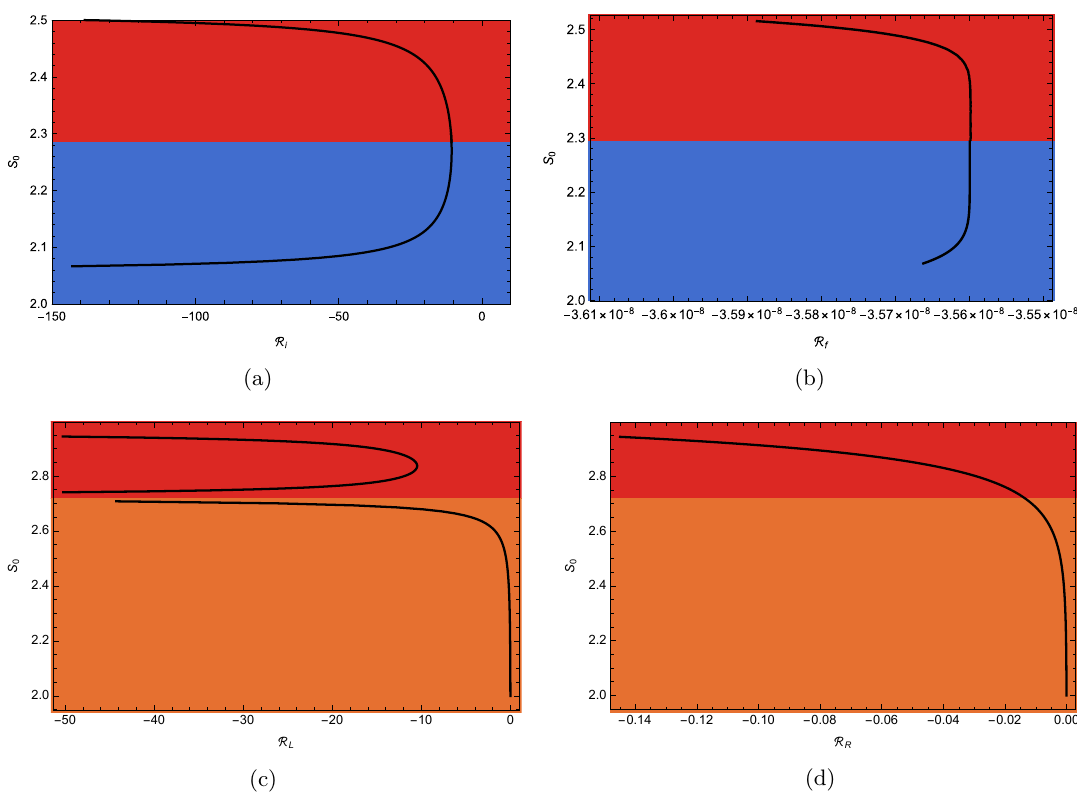
to type W LR region in 1 , 1 1 , 0 to type W LL region, figures (c) and 1 , 1 1 , 2